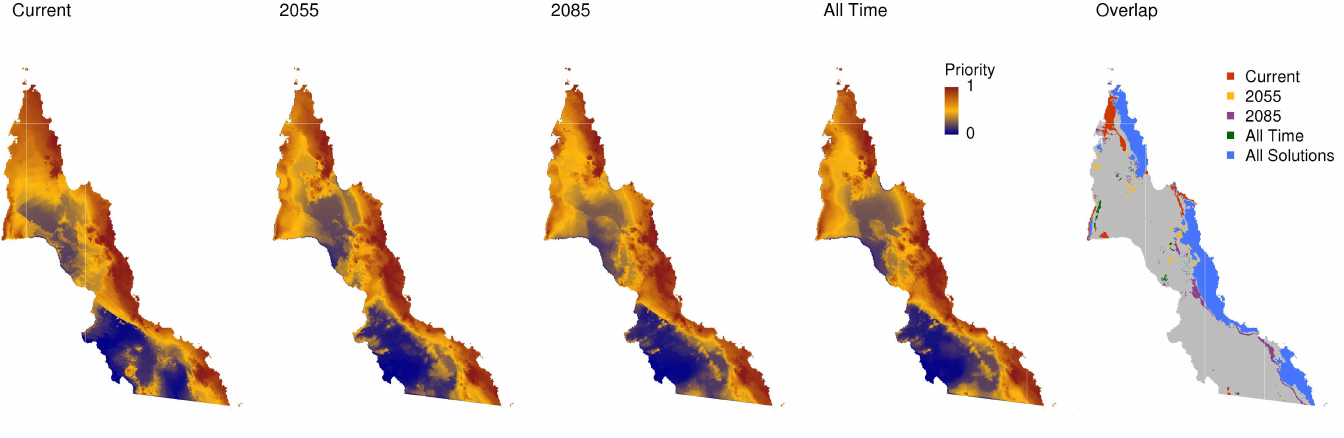
Fig 2. The Zonation solutions for Current, 2055, 2085 and All Time scenarios. The highest ranking cells ranked “1”, shown in red, and the lowest-ranking cells ranked “0”, in blue. Far right: the highest-ranking cells ( > top 25%) showingwhere all solutionsoverlap, and areas only found in the highest-ranking cells for the Current, 2055, 2085 or All Time scenarios. The grey represents areas that were not in the highest-ranking cells for any